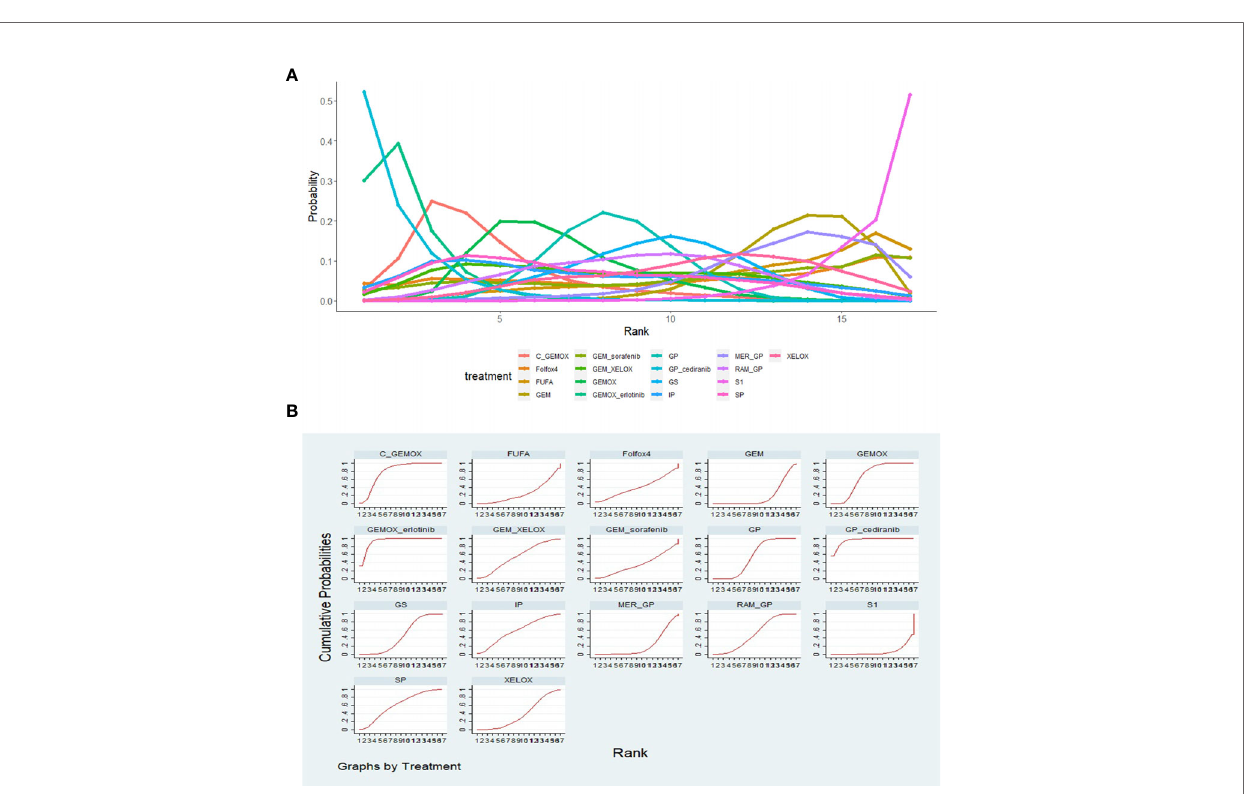
FIGURE 6 | (A) The ranking line chart of objective remission rate (ORR); (B) the surface under the cumulative ranking (SUCRA) diagrams of